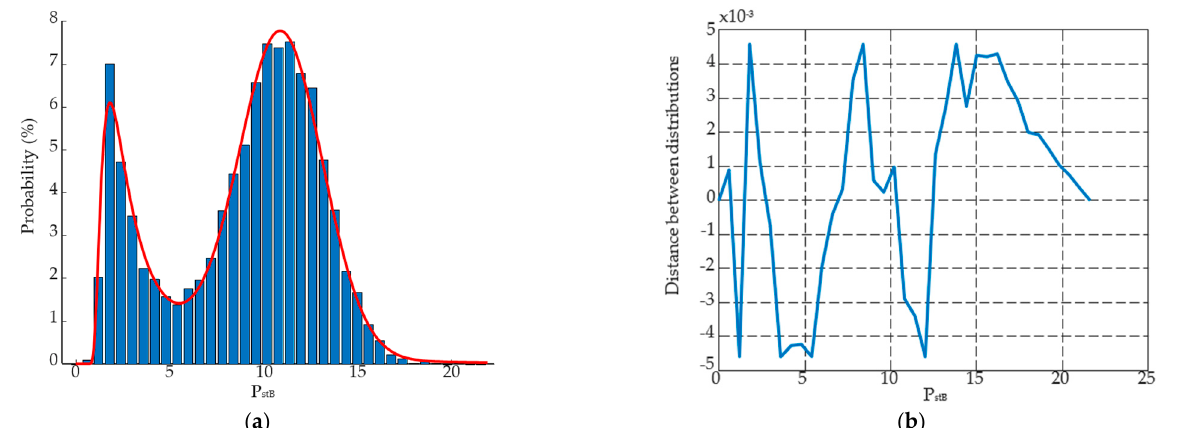
Figure 7. Adjustment of the P st indicator density for a distribution of voltage of 110 kV: ( a ) histogram with the determined distribution, ( b ) differences between distributions.